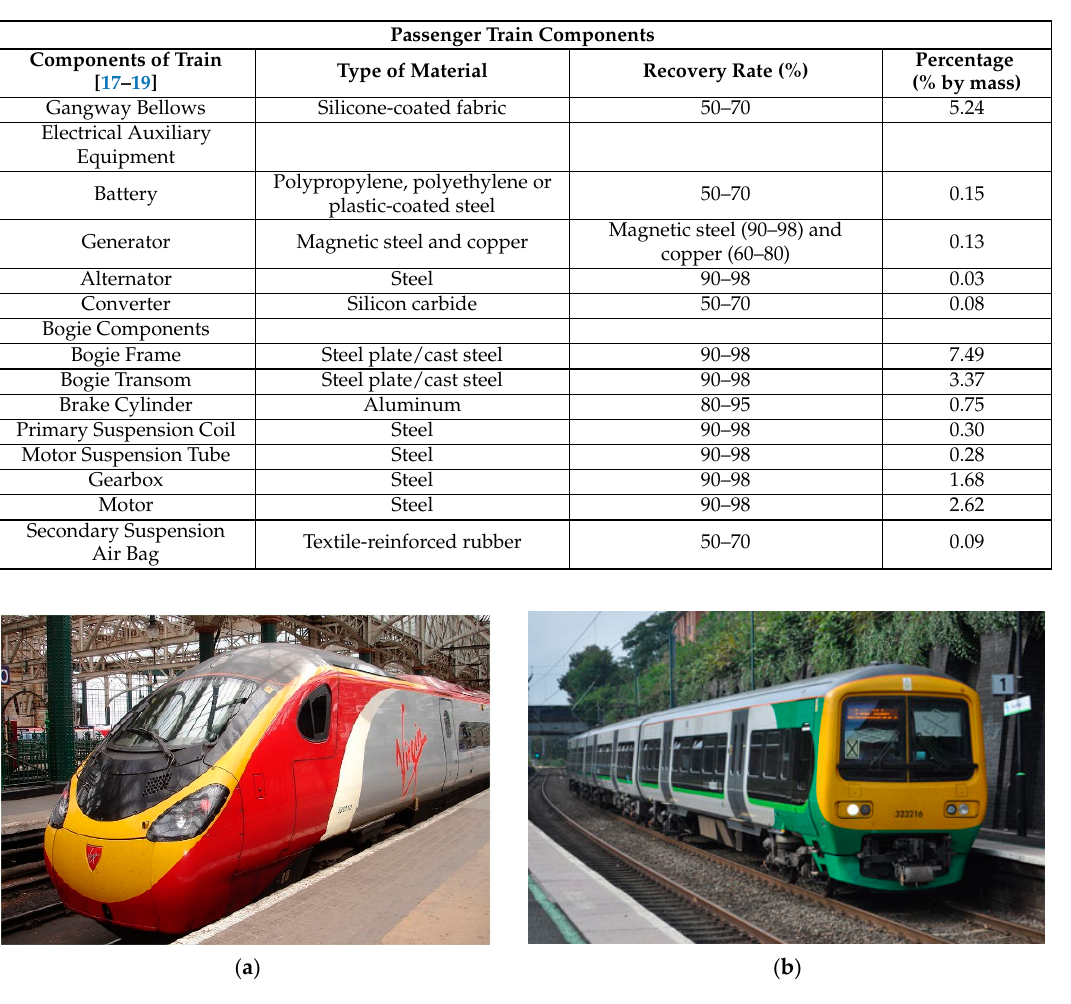
Figure 2. Passenger rail cars: ( a ) Virgin Trains, ( b ) London Midlands